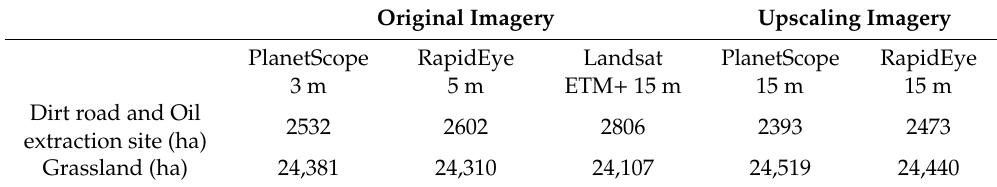
Table 3. Comparison of classification performance by classes.